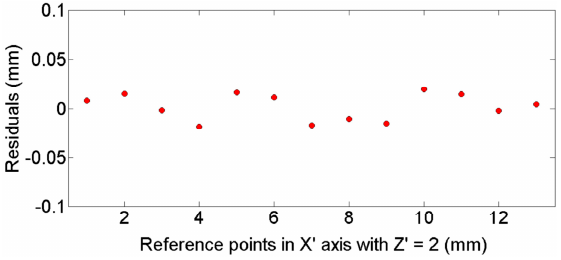
Figure 11. Residual of reference point positions along the X’ axis using the 2 mm calibration block [22].